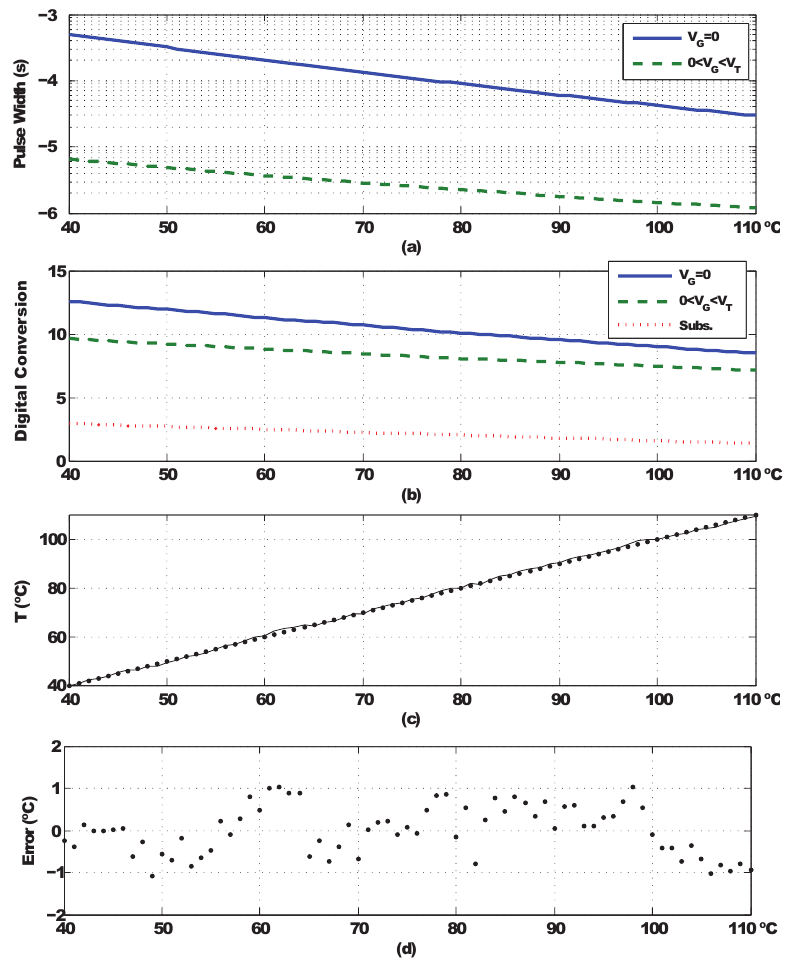
Figure 7. Characterization of the sensor under nominal